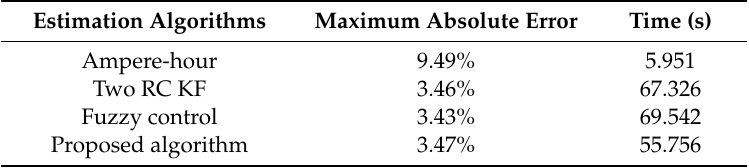
Table 3. Computing time (s) and error of various SOC estimation algorithms.